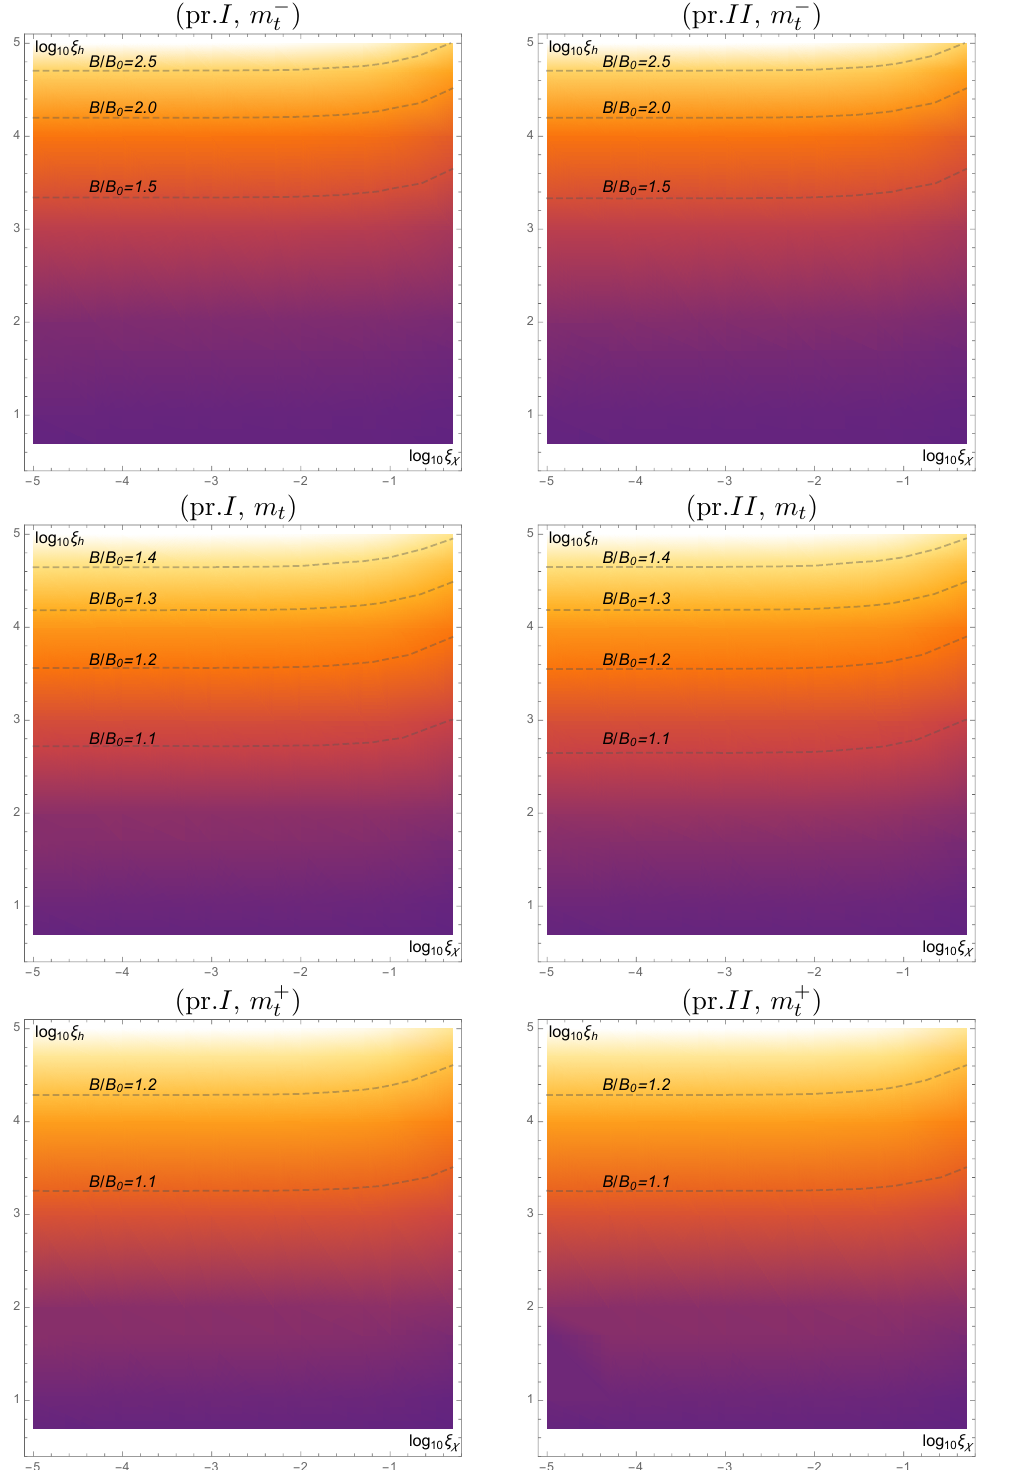
Figure 3. (See section 3.4 for explanation.) The ratio B=B 0 for the two choices of the normalization point (pr. I , II ). We take the Higgs mass m H = 125 : 09 GeV [8], and the top masses m t = 173 : 34 GeV and m (cid:6) = 173 : 34 (cid:6) 1 : 52 GeV, corresponding to the 2 (cid:27) experimental uncertainty region [7]. t